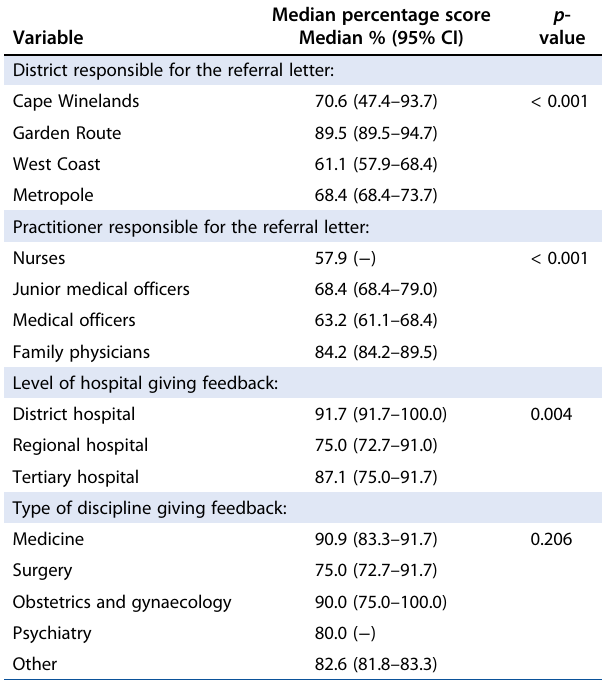
Table 9: Factors related to the quality of written referrals and